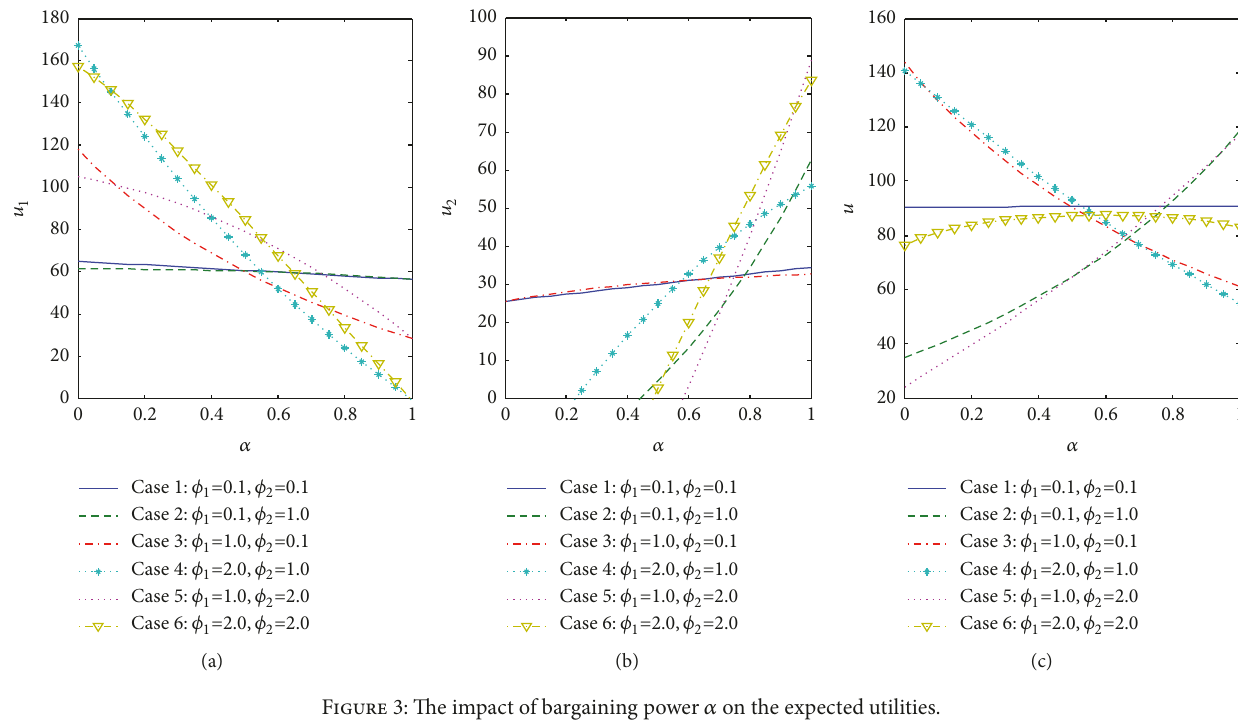
Figure 3: The impact of bargaining power 𝛼 on the expected utilities.